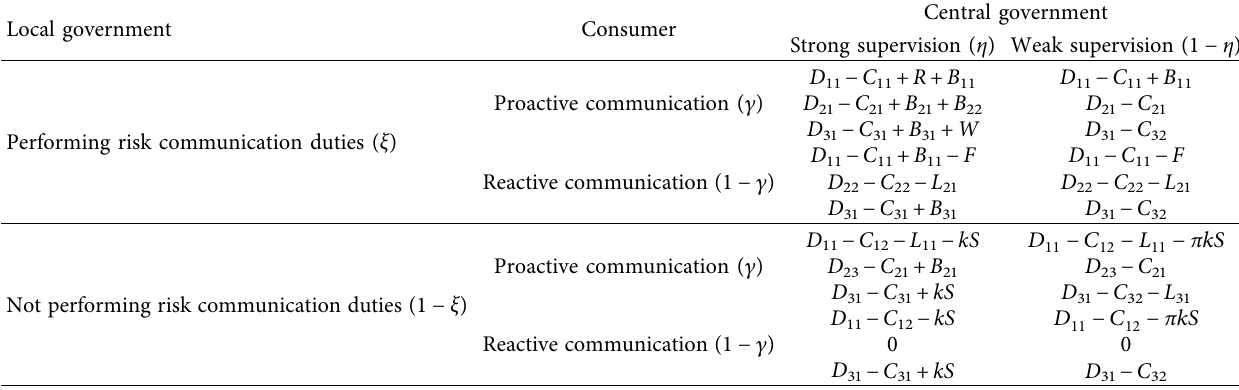
Table 2: Payoff matrix of the tripartite